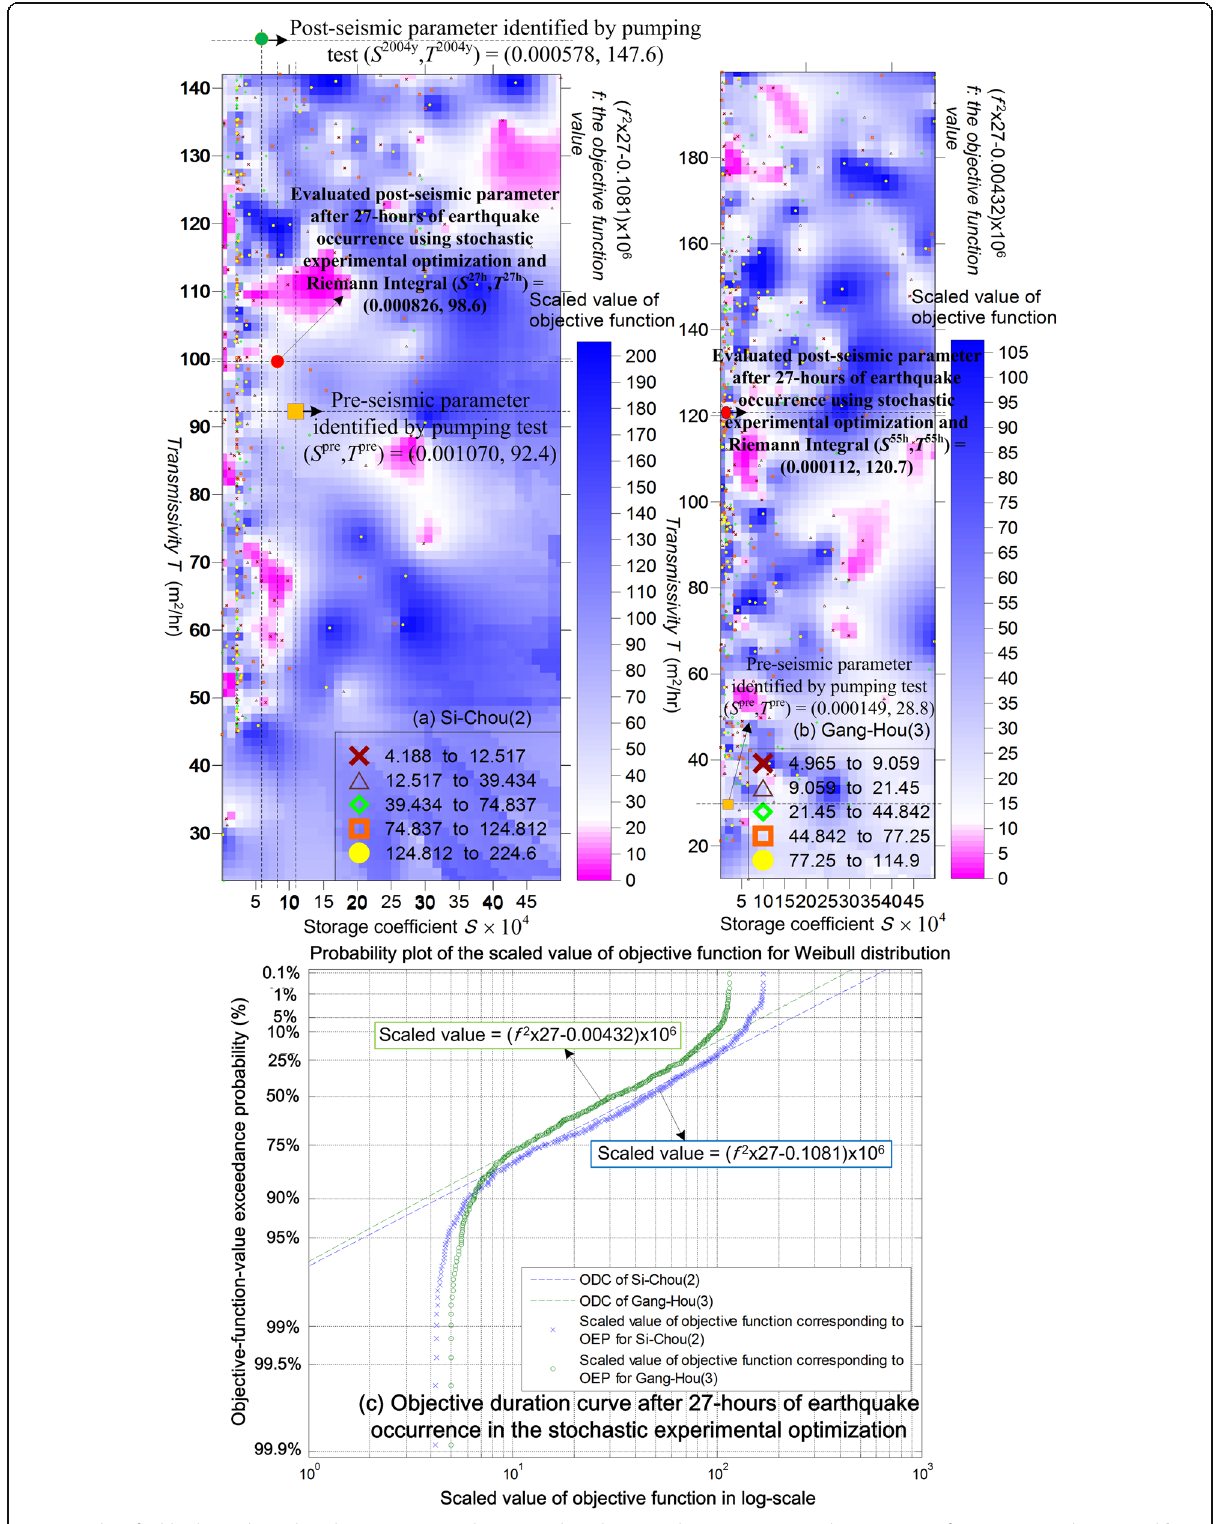
Fig. 15 Identified hydrogeological evolution pattern 27 h post-earthquake in stochastic experimental optimization for zones a Si-Chou(2) and b Gang-Hou(3) associated with the ( c ) objective function value duration curves